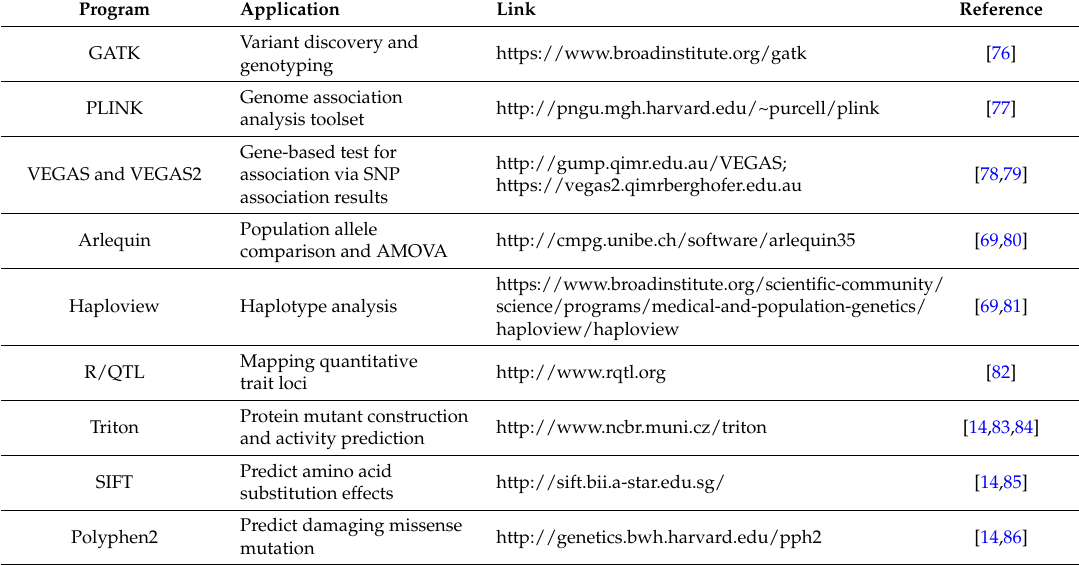
Table 5. Programs for SNP